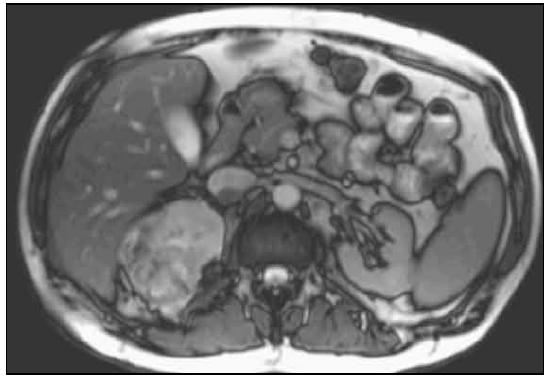
FIGURE 2. Axial MRI image of the right kidney demonstrating a mass in the midpole region and a thrombus in the